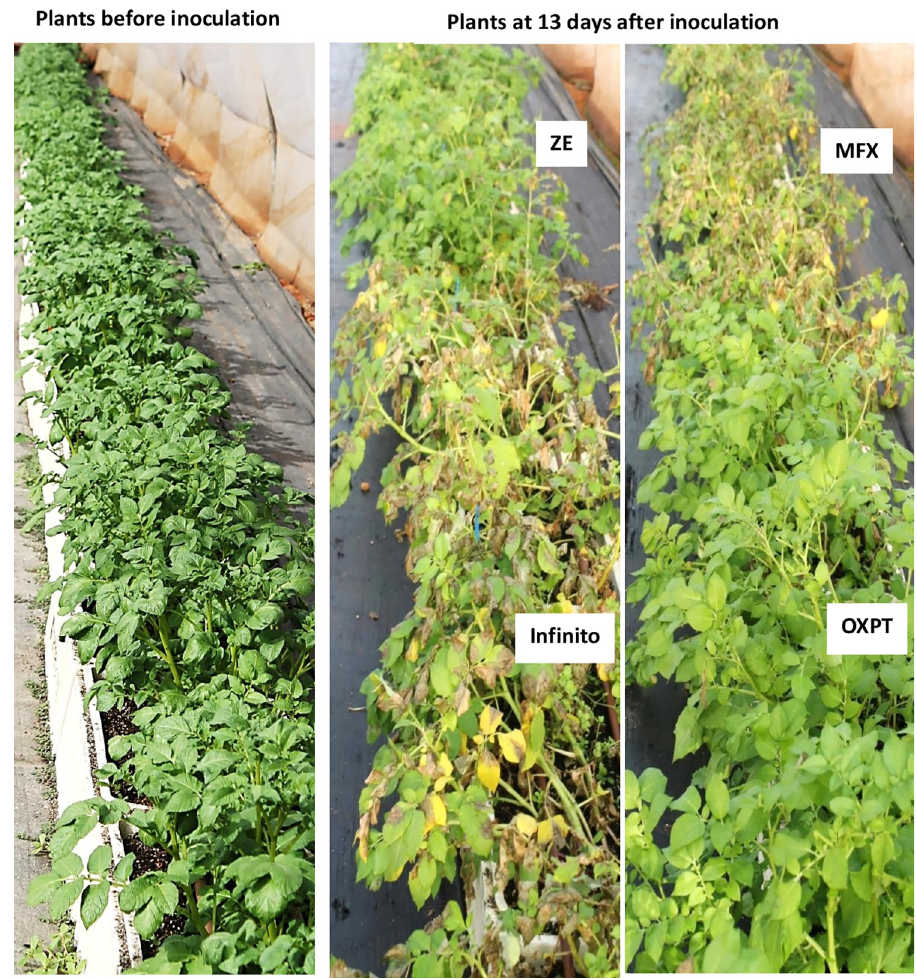
inoculated with sporangial suspension of Phytophthora infestans . Photos of the infected plants (middle and right panels) were taken at 13 dpi. ZE, MFX, Infinito and OXPT, all applied at 50 mg ai per 5 plants in a